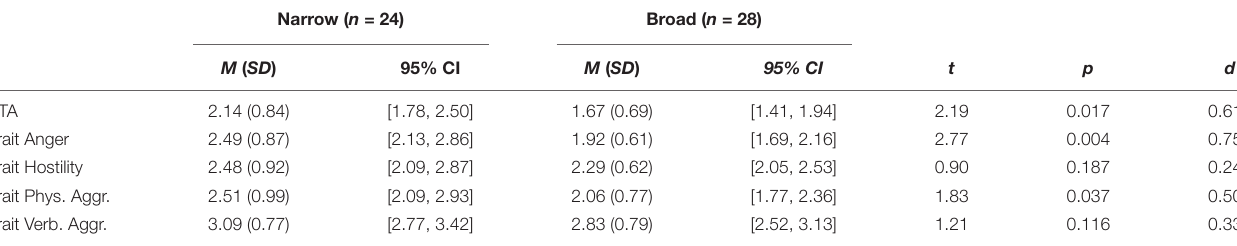
TABLE 2 | Effect of cognitive scope condition on attitudes toward anger and trait aggression subscales – Study